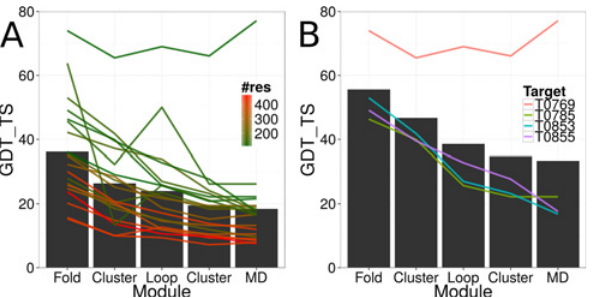
Fig 3. Model accuracy decay over the course of the protein structure prediction pipeline. (A) The model accuracy decayed over the course of the protein structure prediction pipeline. The black bars show the average GDT_TS value of the most accurate model over all twenty regular targets after each pipeline module. The lines show the development of model accuracy for each target over the course of the pipeline. The coloring is according to the number of residues in the protein target. (B) Same as in (A) for four selected targets with a GDT_TS value of greater than 40% after the first clustering